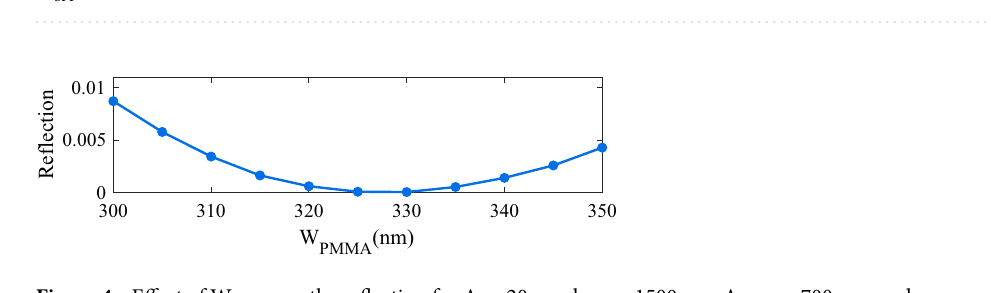
Figure 3. Effect of Ag thickness on the reflection and the resonance frequency of surface plasmon polariton (λ SPP ).